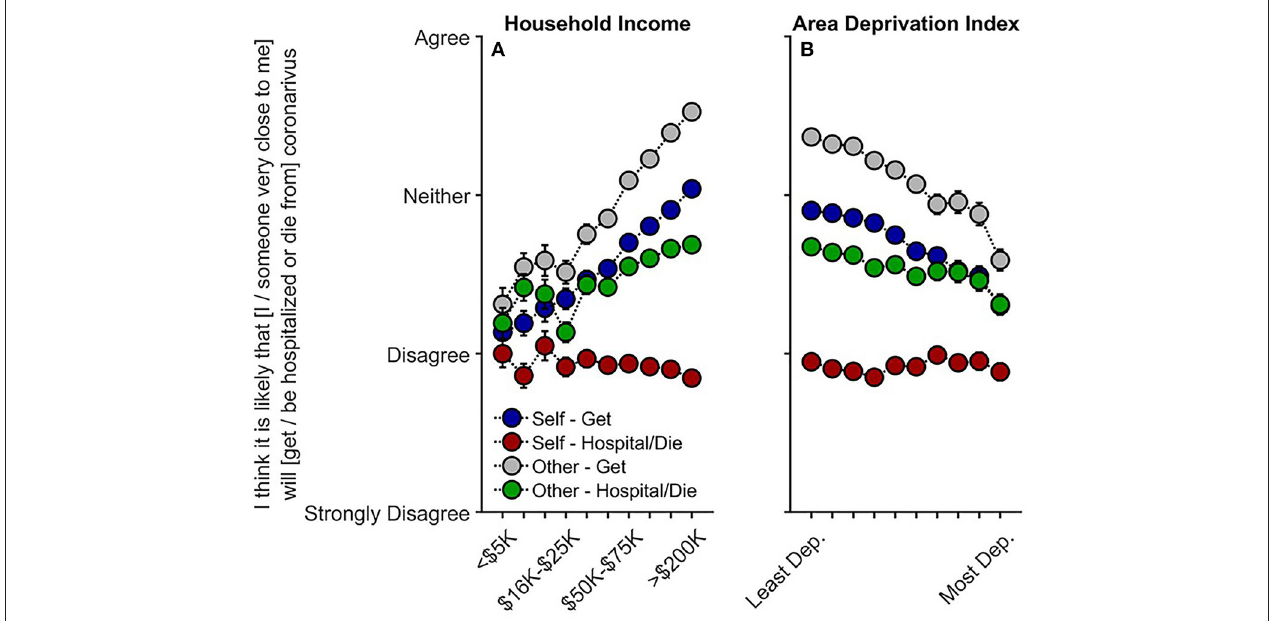
FIGURE 2 | Caregivers’ perceived risk of their (or someone close to them) getting and being hospitalized/dying from COVID-19 as functions of (A) annual household income and (B) their home census tract’s area deprivation index. With respect to questionnaire item wording, “Self” refers to “I,” and “Other” refers to “someone very close to me.” Error bars are ± 1 between-subjects standard error of the means. Analyses controlled for caregiver education, caregiver race, caregiver ethnicity, questionnaire number, participants’ baseline study site, and participant. Area deprivation index was collapsed across continuous deciles for graphing. Dep.,